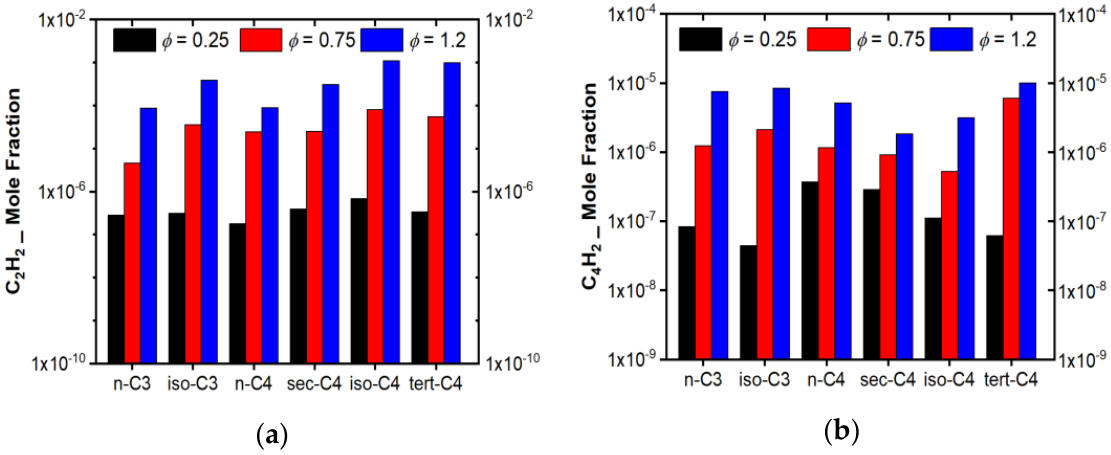
Figure 15. Model prediction for the peak value of ( a ) C 2 H 2 , and ( b ) C 4 H 2 mole fraction from the oxidation of propanol and butanol isomers during the ignition process at 860 K and 36 atm for the unburned fuel/air-mixture.